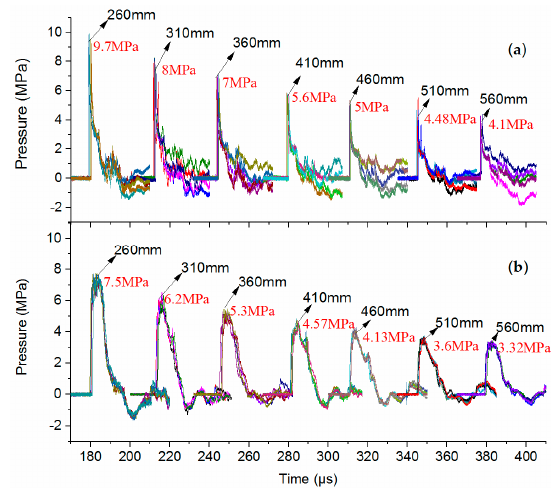
Figure 7. Temporal waveforms obtained by pressure probes vs. distances. ( a ) Müller-plate probe; ( b ) PCB138 probe. ( b ) PCB138 probe.